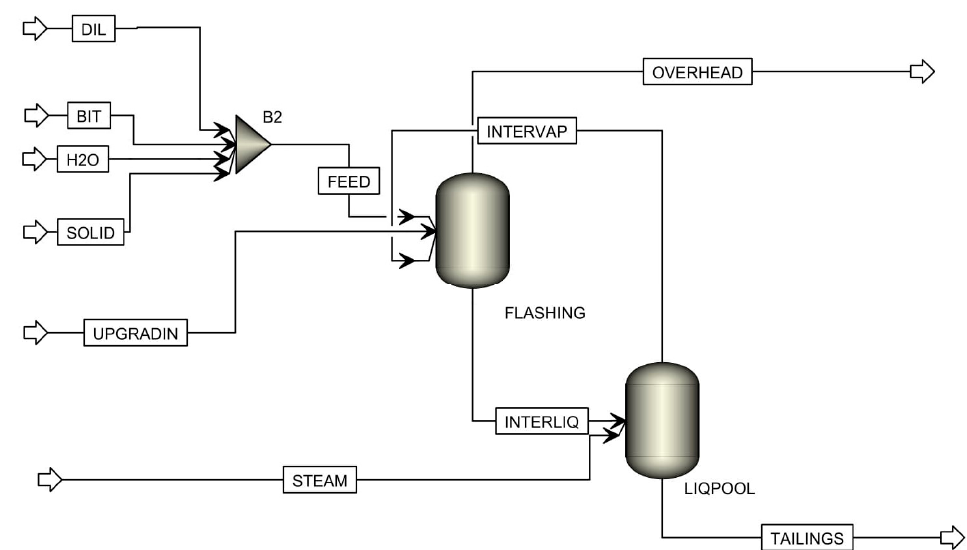
Figure 11. Configuration of the interconnected Flash2 model of the NRU column.